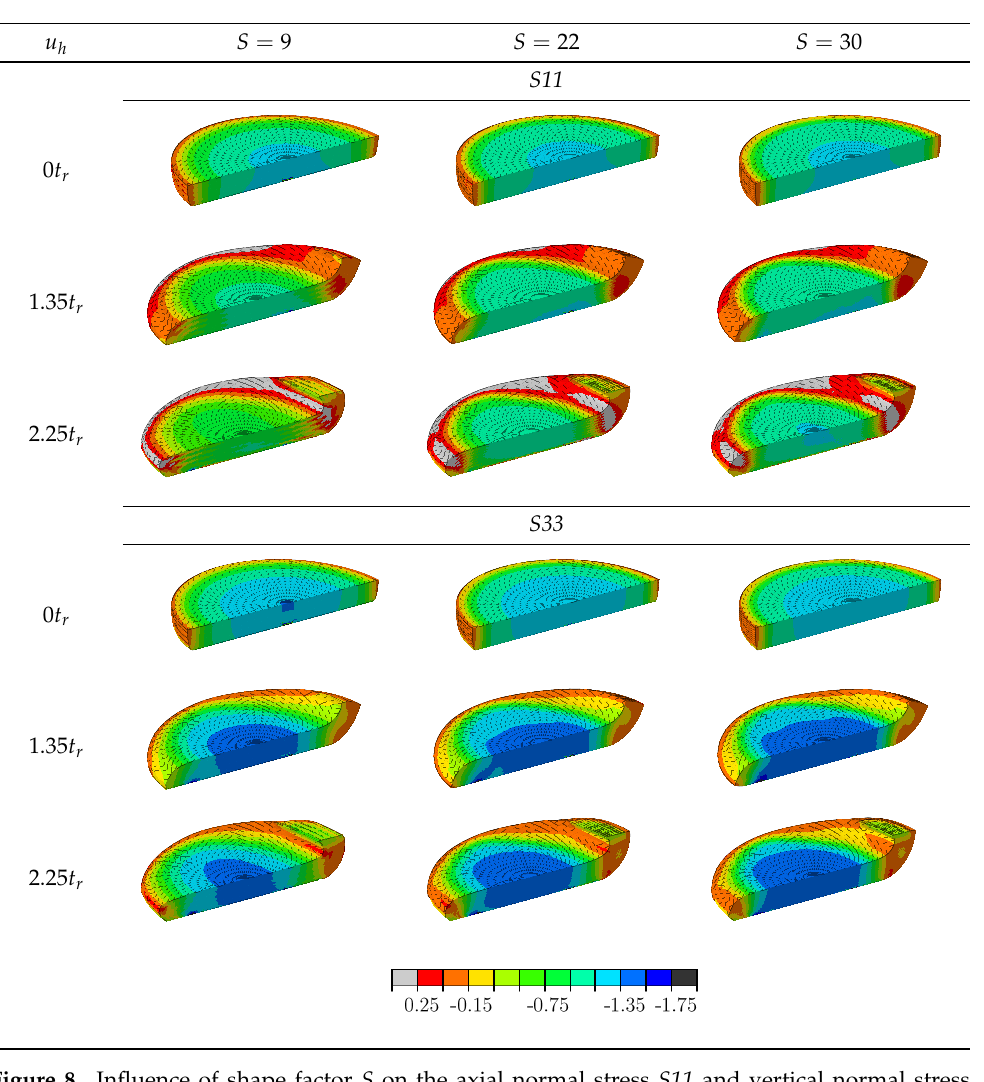
Figure 8. Influence of shape factor S on the axial normal stress S11 and vertical normal stress S33